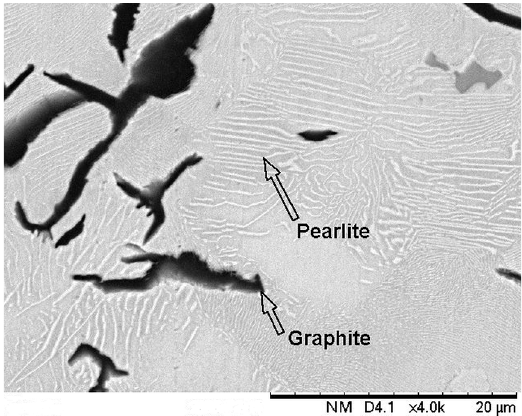
Figure 1. Microstucture as-received of grey cast iron at 500×